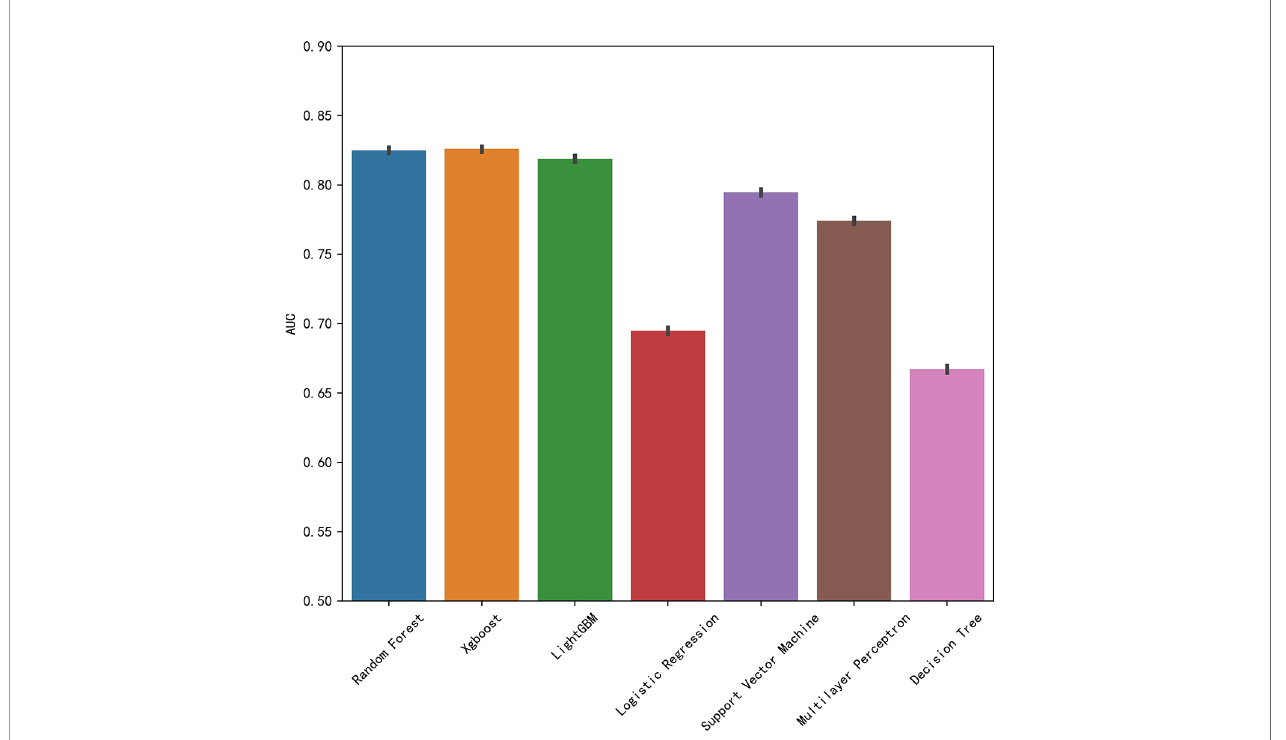
FIGURE 2 | Comparison of AUCs among seven machine learning models with bar